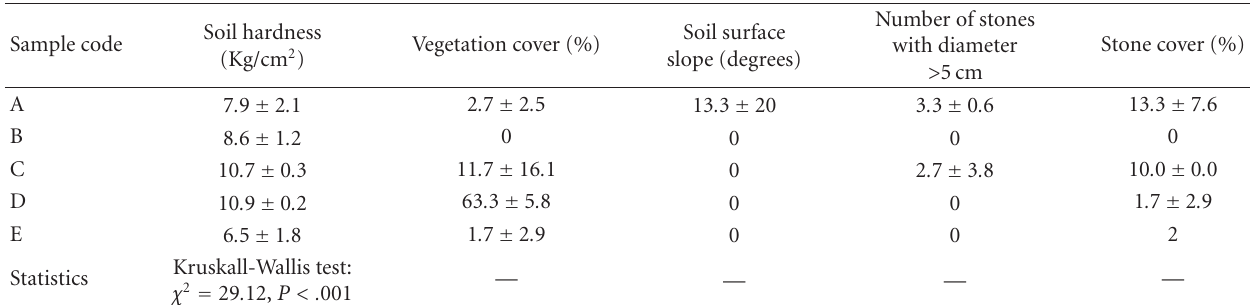
Table 3: Superficial characteristics of the nesting sites of L. malachurum sampled in 2008. Measures were taken at 3 plots of 1m × 1m at each site. Except for soil hardness, which was taken 3 times at each plot (9 measures per site), all the other variables have n = 3, so that statistical comparisons were not